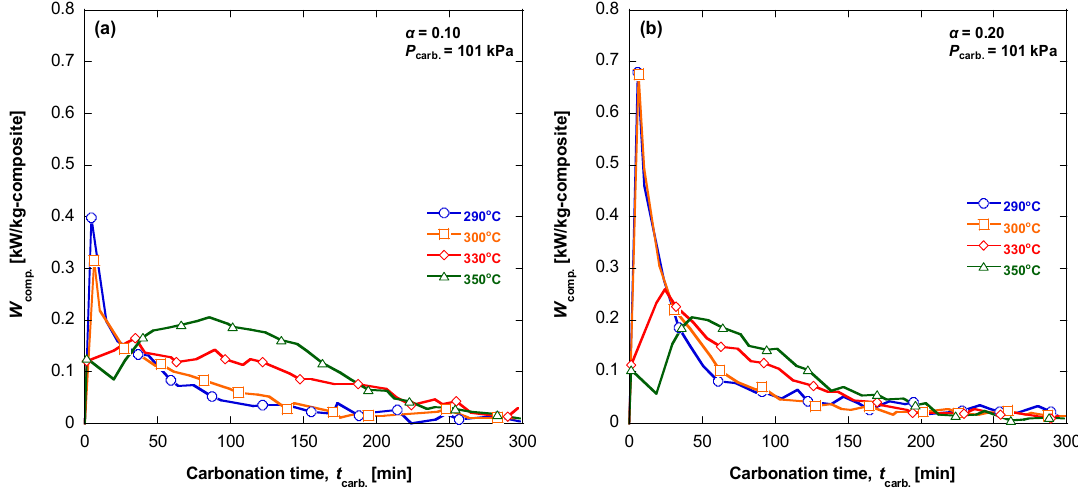
Figure 10. Comparison of heat output rate, W comp. , under various reaction temperature: ( a ) α = 0.10, ( b ) α = 0.20.